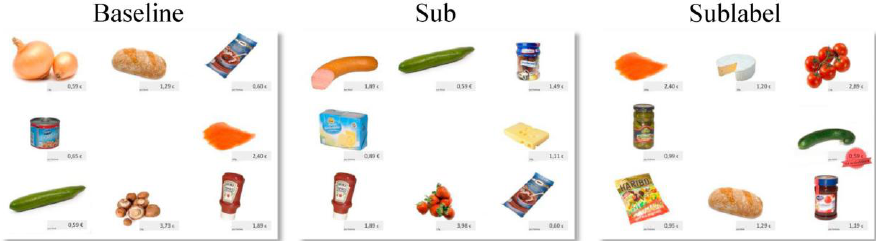
Figure 3. Examples of matrices for the baseline, sub (a damaged package of butter), and